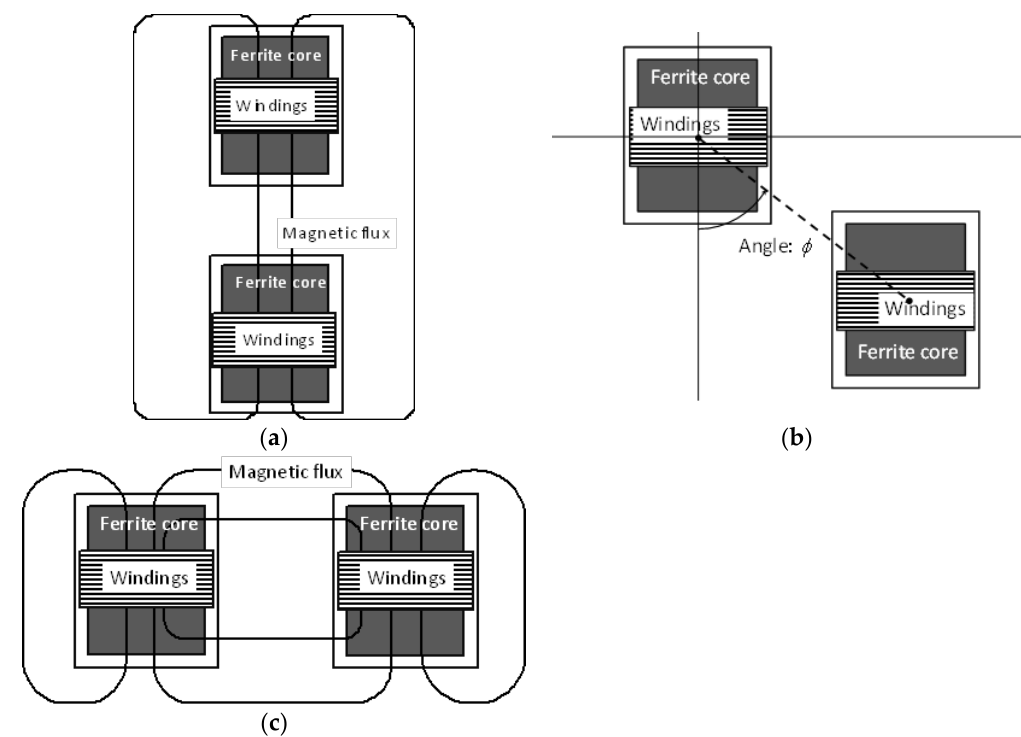
Figure 3. Mutual position of two sets of solenoid pads with mutual position angle Φ . Φ = 0 degrees in ( a ), Φ = 53 degrees in ( b ), Φ = 90 degrees in ( c ).